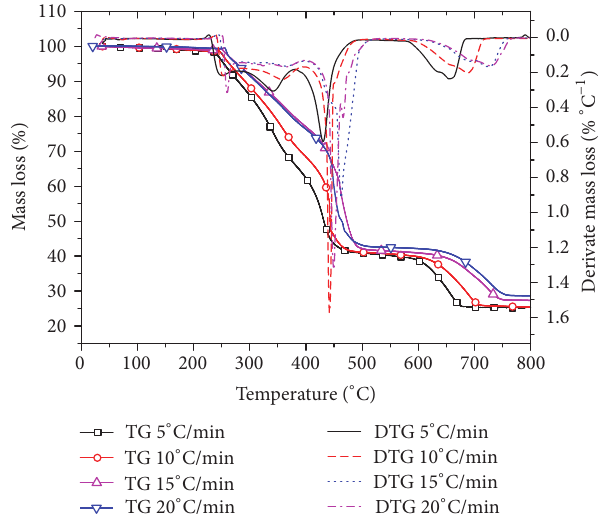
Figure 5: Thermal decomposition of latex